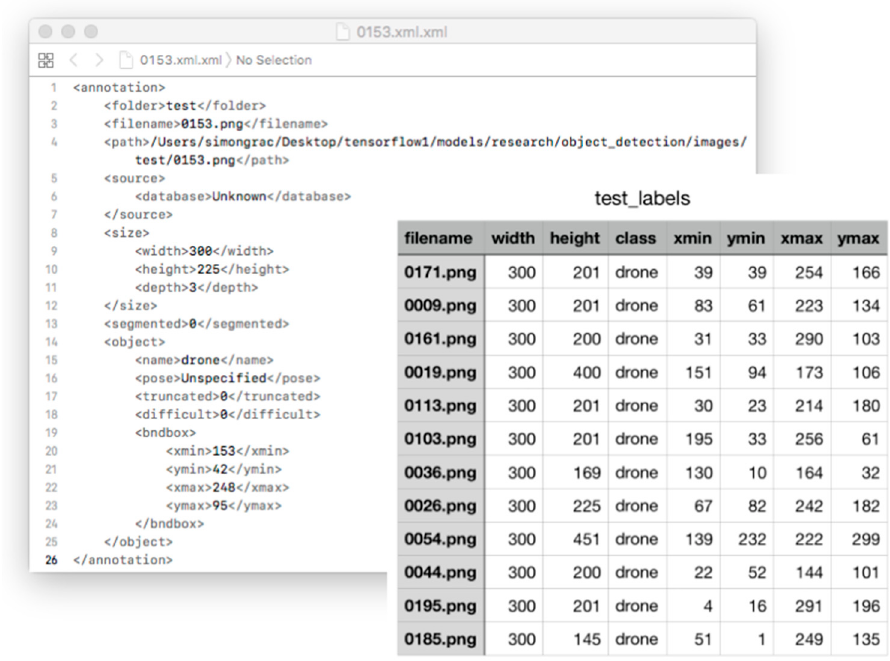
Figure 14. The creation of TensorFlow Records (TFRecords).